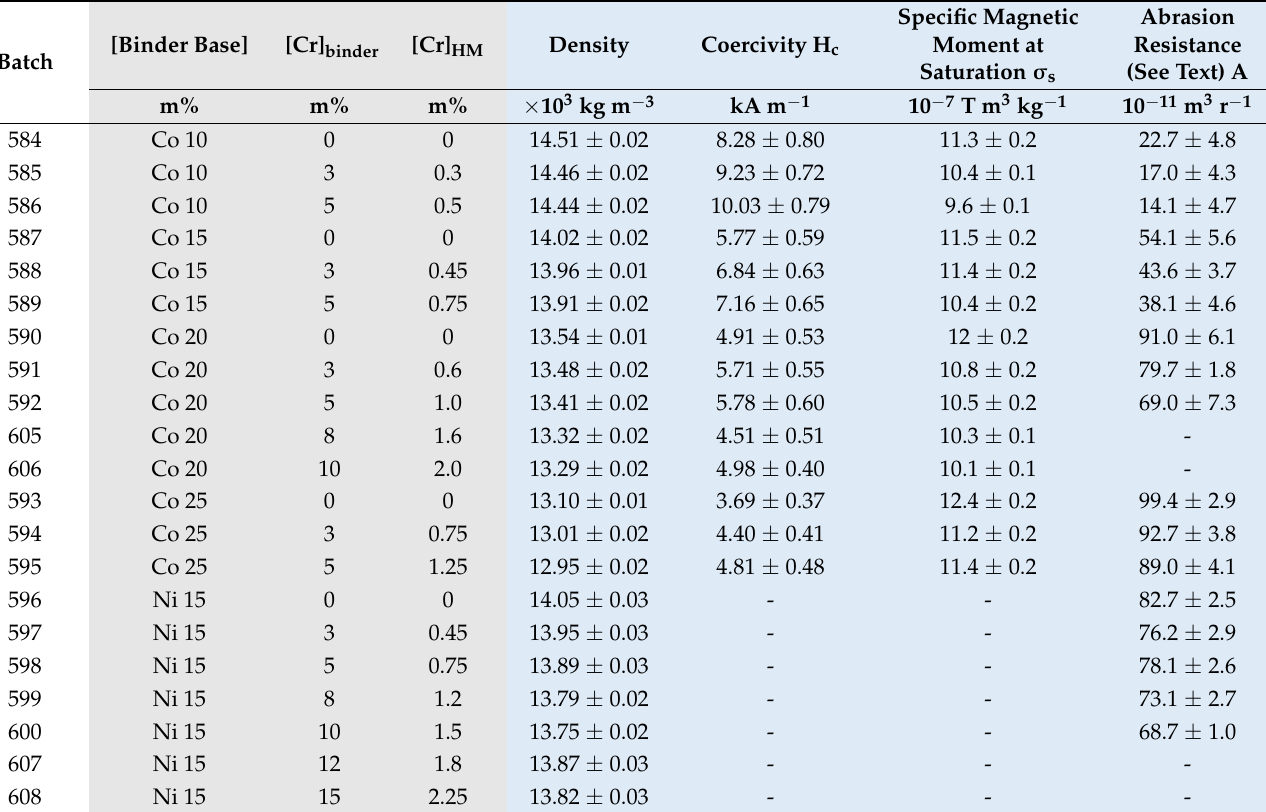
Table 2. Composition and metallurgical characterization of Co- and Ni-based grades, with a system- atic variation of Cr